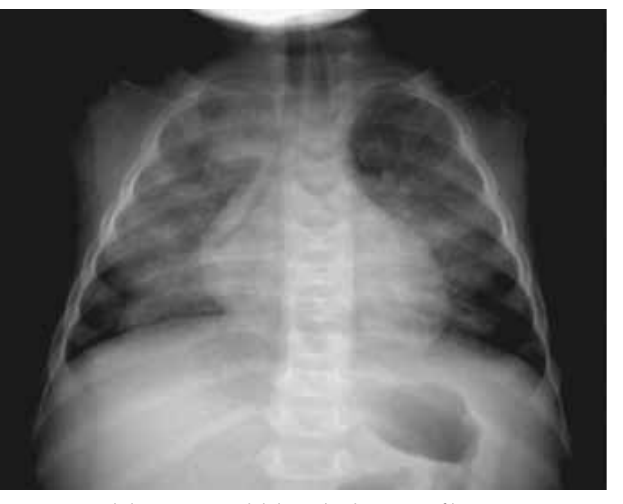
Fig. 4. Cropped chest image with bilateral pulmonary